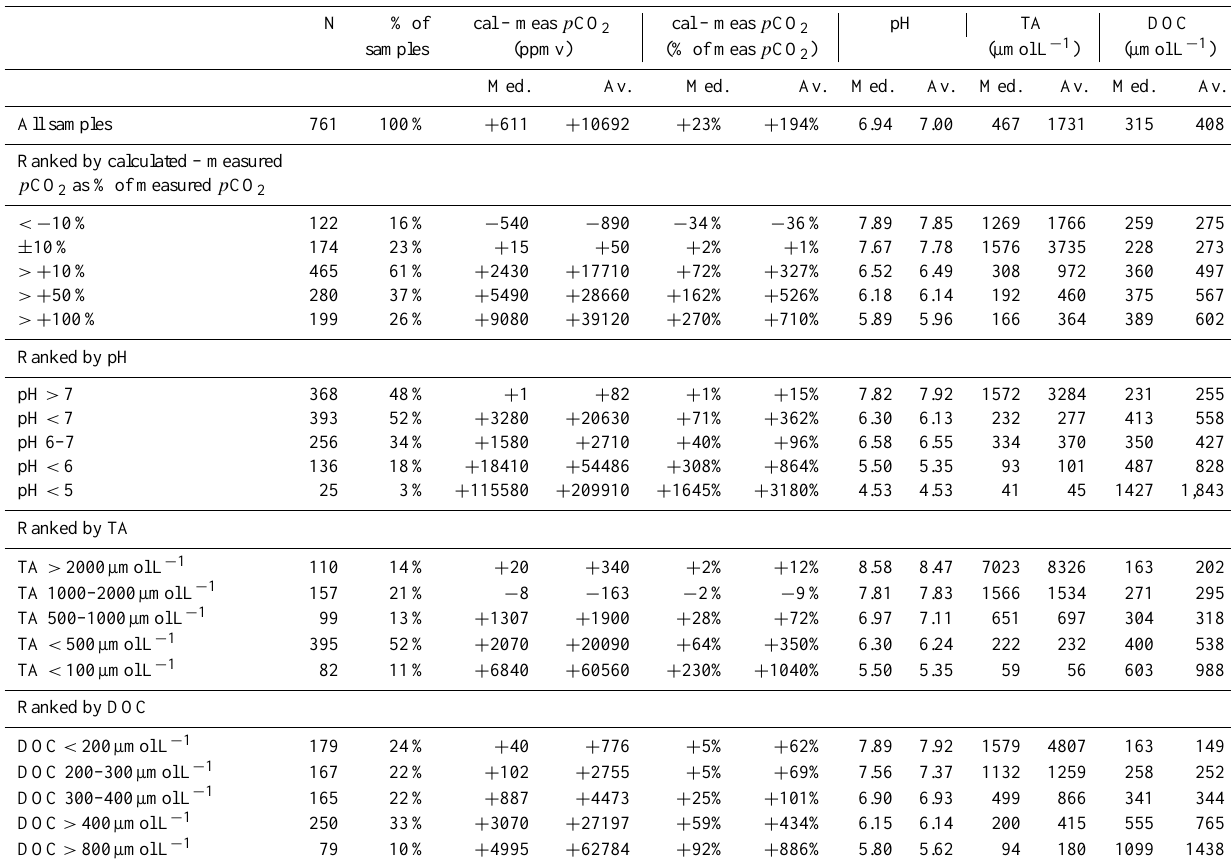
Table 2. Median and average values of DOC, pH (measured on the NBS scale), total alkalinity (TA), and calculated minus measured p CO 2 in the data